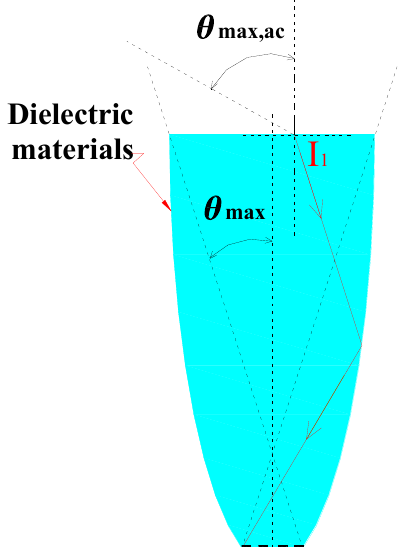
Figure 2. Working principle of the solid dielectric CPC.